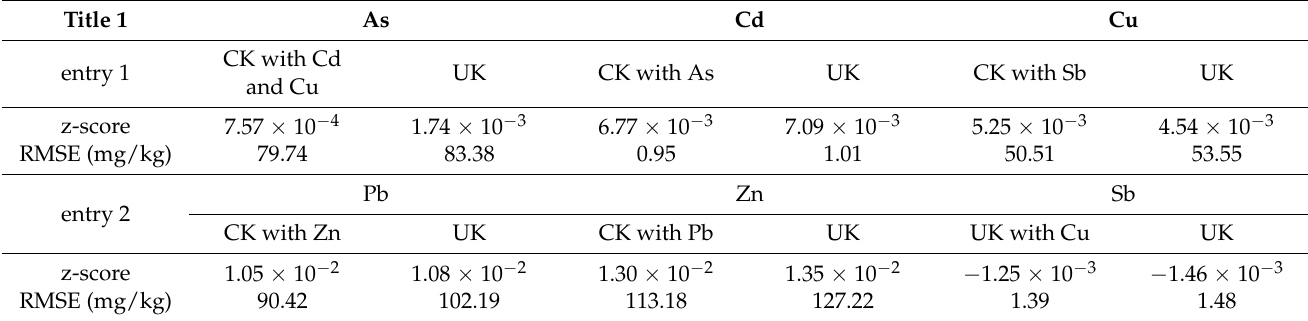
Table 2. Cross-validation results for cokriging and universal